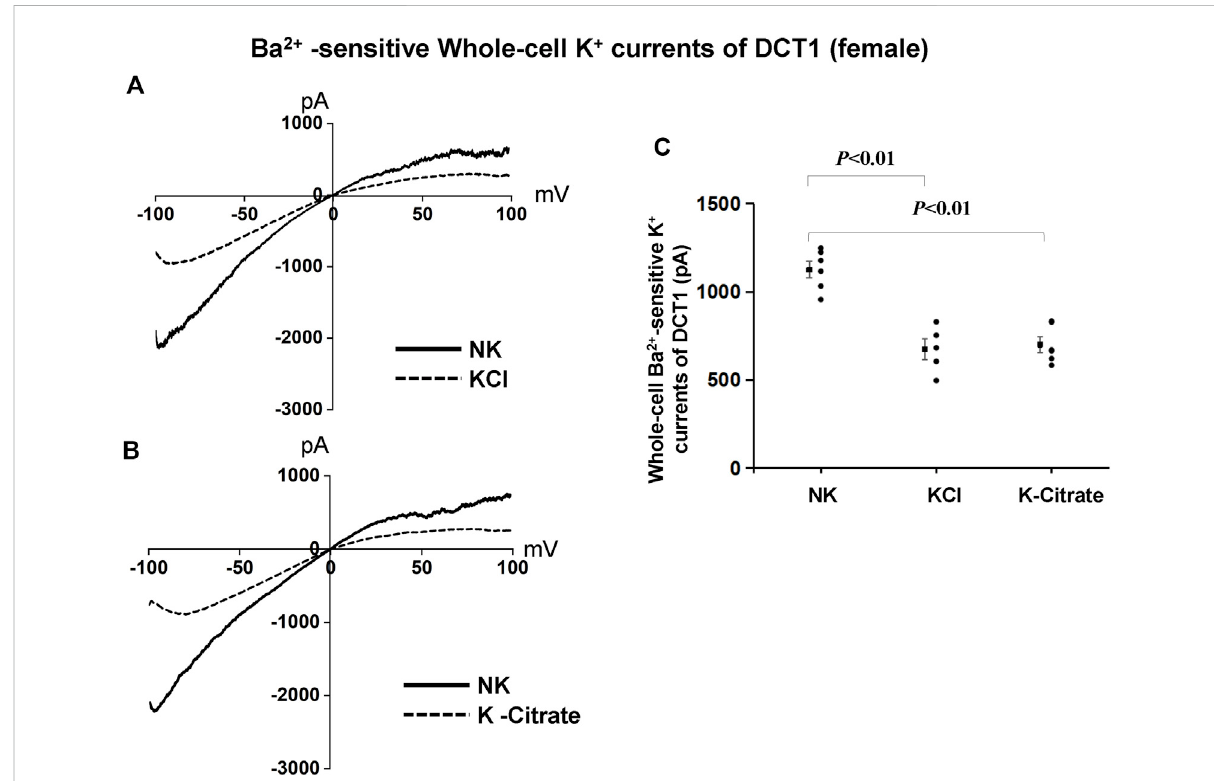
FIGURE 6 Cl − contentofHKdietsdoesnotaffectHK-inducedinhibitionofKir4.1/Kir5.1currentsoftheDCToffemalemice.Asetofwhole-cellrecordings shows Ba 2+ (0.1 mM)-sensitive Kir4.1/Kir5.1-mediated K + currents in the DCT of female mice on NK or 5% K-Cl diet for 7 days (A) and on NK and K-citratefor7 days (B). Thewhole-cellK + currentsweremeasuredwithrampprotocolfrom − 100to100 mVusingsymmetrical140